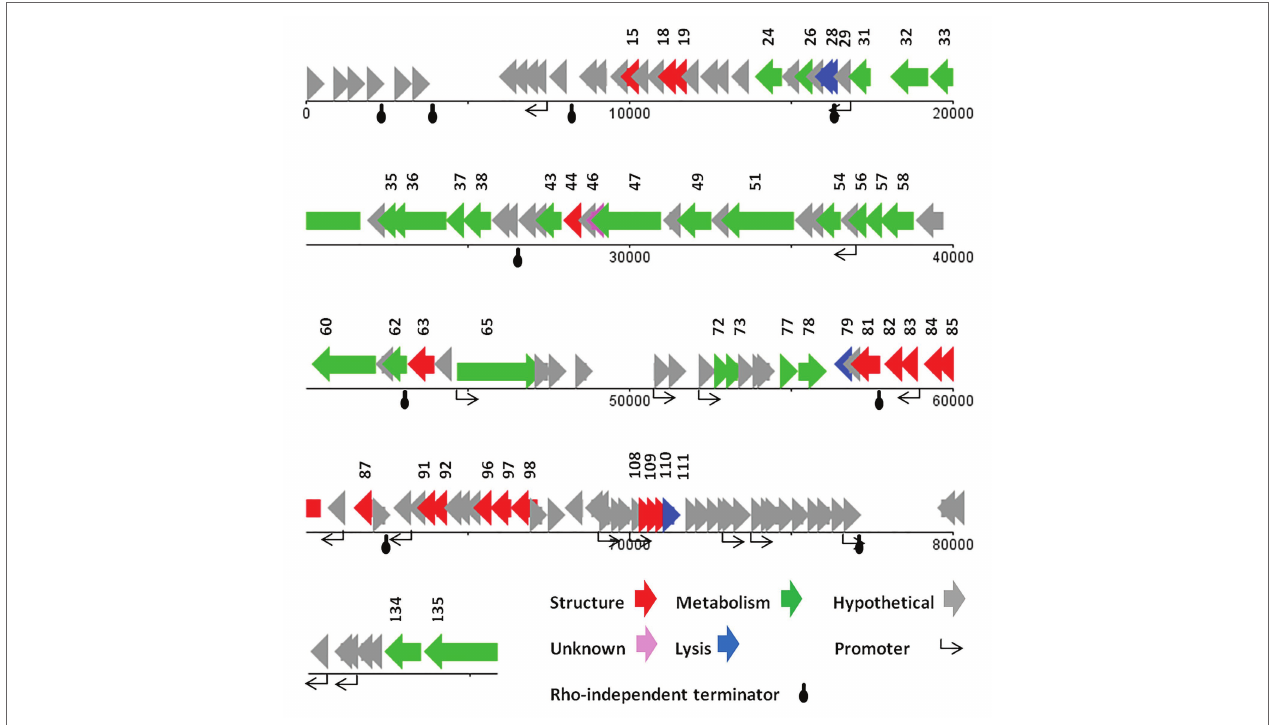
FIGURE 3 | The linear genome map of phage